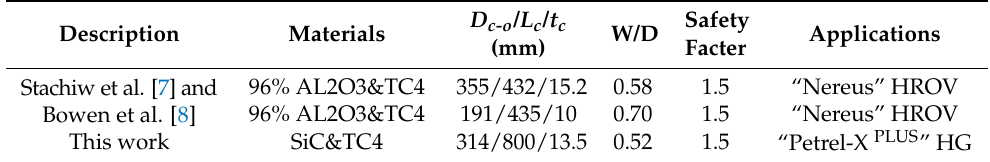
Figure 12. Hydrostatic pressure experiment of the SiC&TC4 ceramic pressure housing. ( a ) SiC&TC4 ceramic pressure housing loaded into the high-pressure chamber; ( b ) Hydrostatic pressure curve (three cycles from 0 to 110 MPa). Table 5. Comparison with other 11,000 m class ceramic pressure